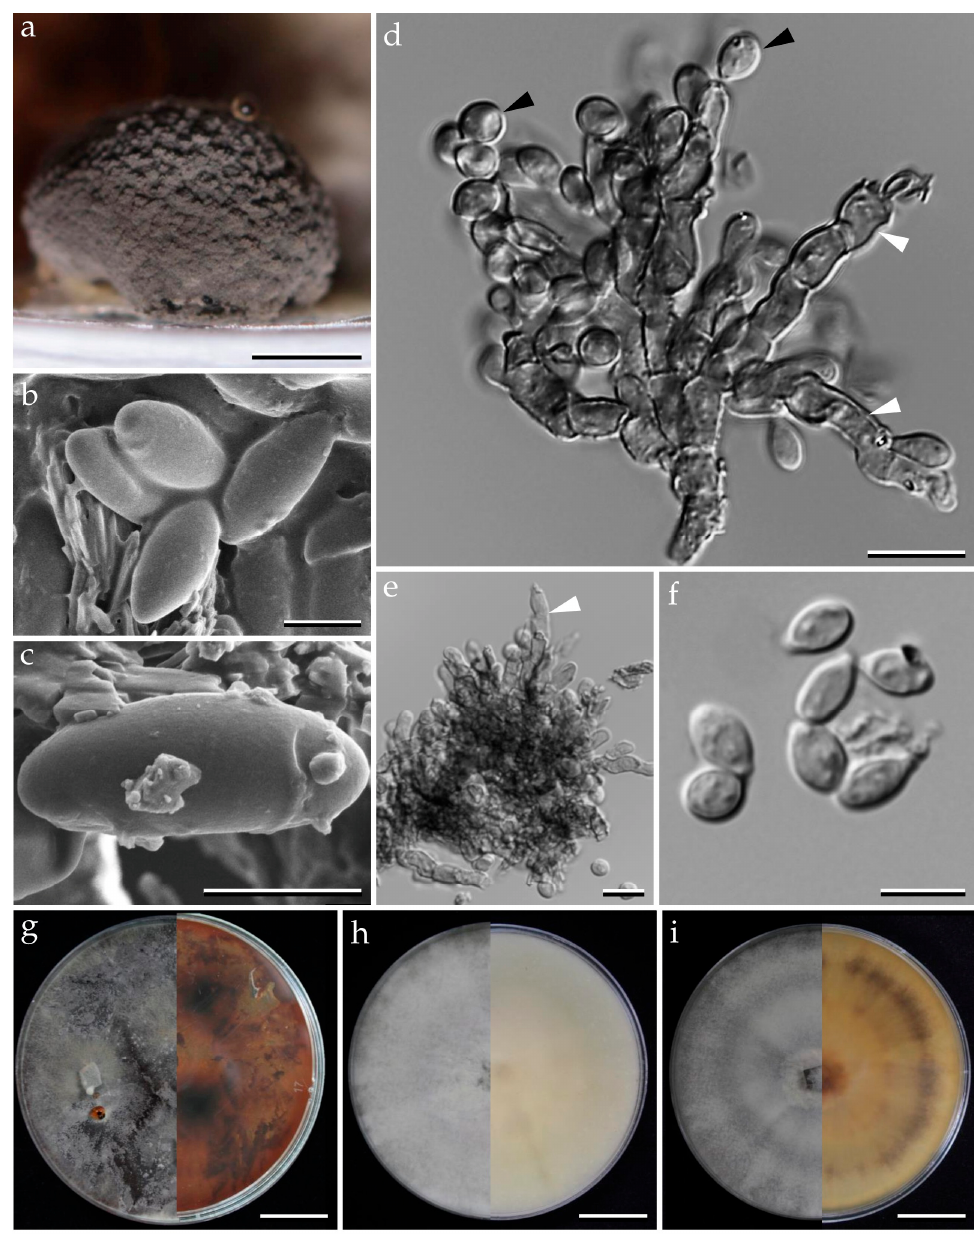
Figure 13. Pyrenopolyporus tonngachangensis strain BCC31553. ( a ) Primordia; ( b , c ) ascospores by SEM; ( d , e ) conidiogenous cells (indicated by white arrows) and conidia (indicated by black arrows); ( g ) colony on PDA after one month; ( h ) colony on OA after one month; ( i ) colony on YMGA after one month. Scale bars: ( a ) = 2 mm; ( b , c ) = 5 µm; ( d – f ) = 10 µm; ( g – i ) = 2 cm.